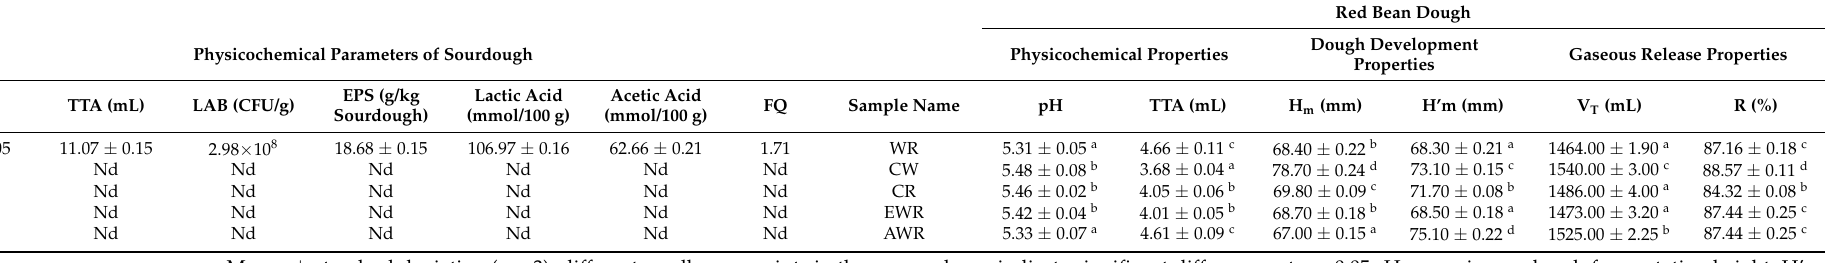
Table 1. Physicochemical properties of red bean sourdough and its effect on dough development and gas production of the resultant dough and their respective